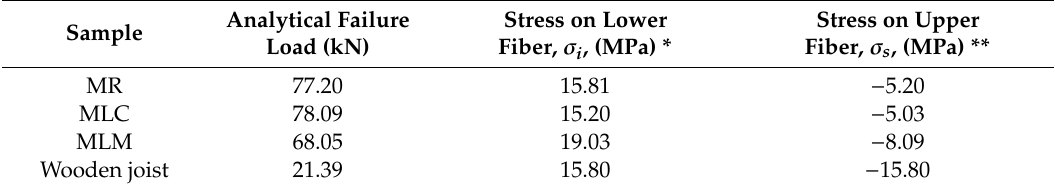
Table 7. Analytical